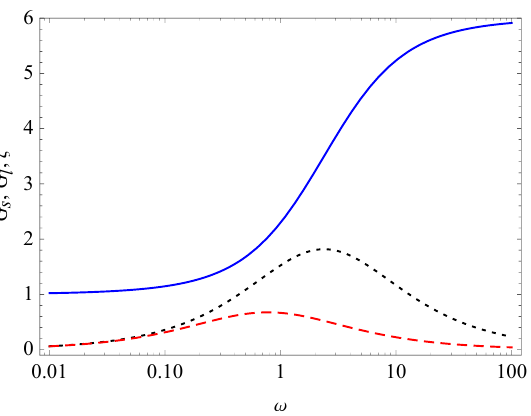
Figure 1. Curves of G s (solid line), G l (dotted line), and ζ (dashed line) versus ω for a = 0.5, b 0 = 1, b 1 = 3, and α = 0.8 in the fractional Zener model (48).